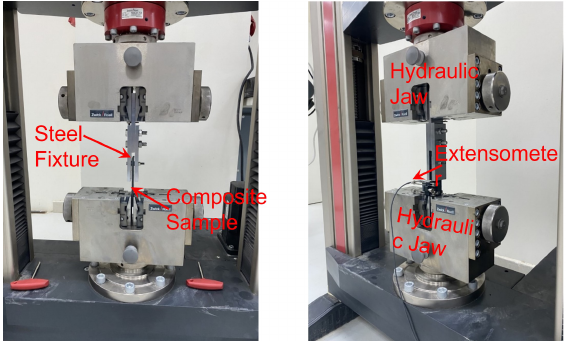
Figure 3. Experimental setup and test fixture for double lap bolted